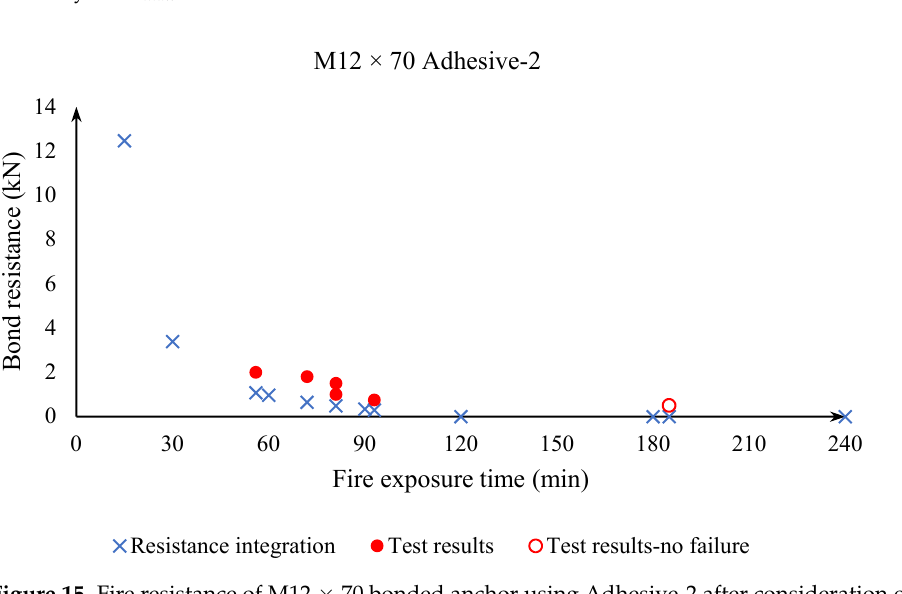
Figure 15. Fire resistance of M12 × 70 bonded anchor using Adhesive-2 after consideration of bond stress beyond T max .